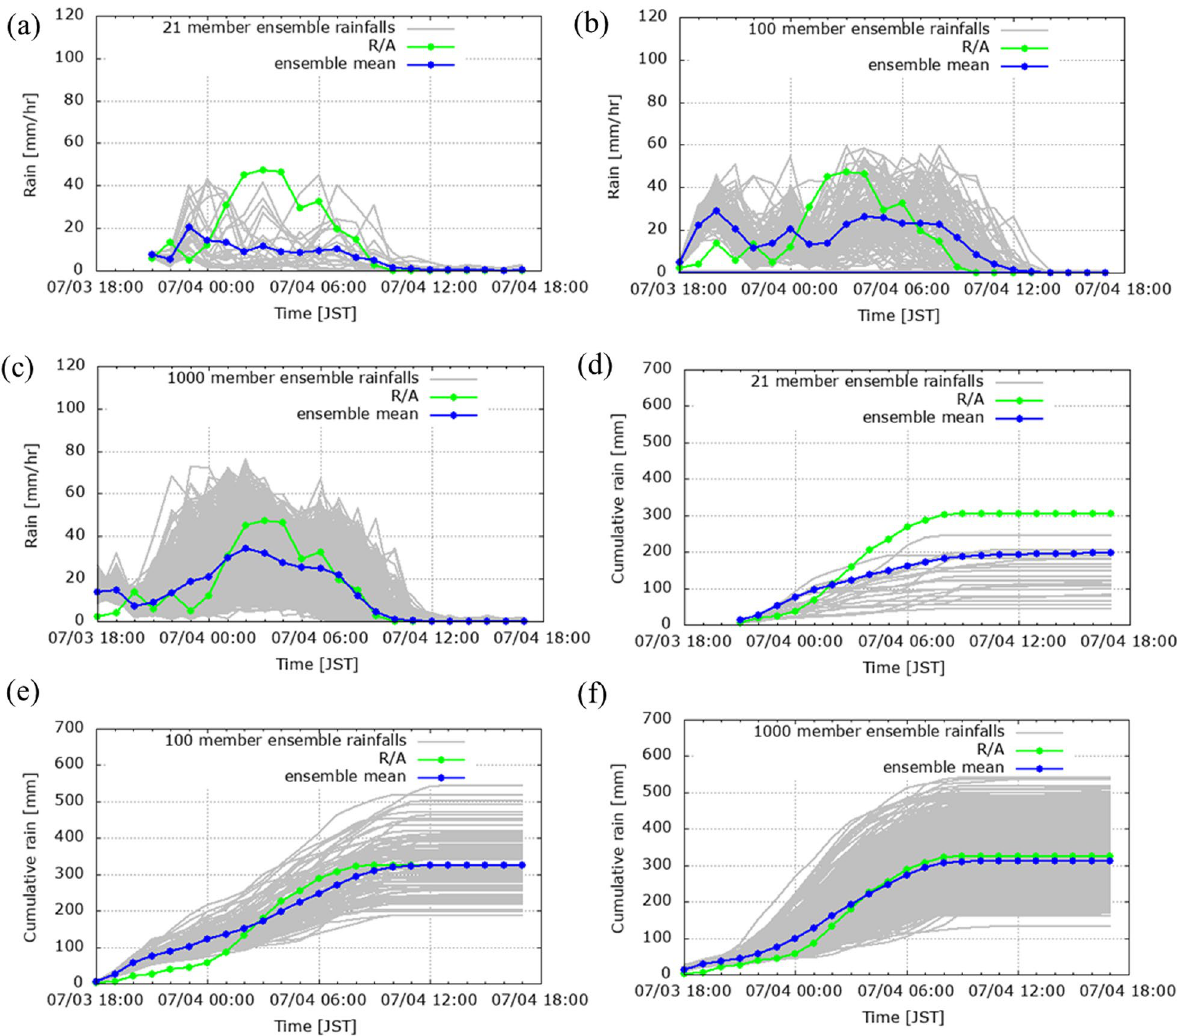
Fig. 12 Observed and simulated basin-average rainfalls for Kawabegawa dam catchment. a – c Hourly rainfall intensity of ( a ) 21 members